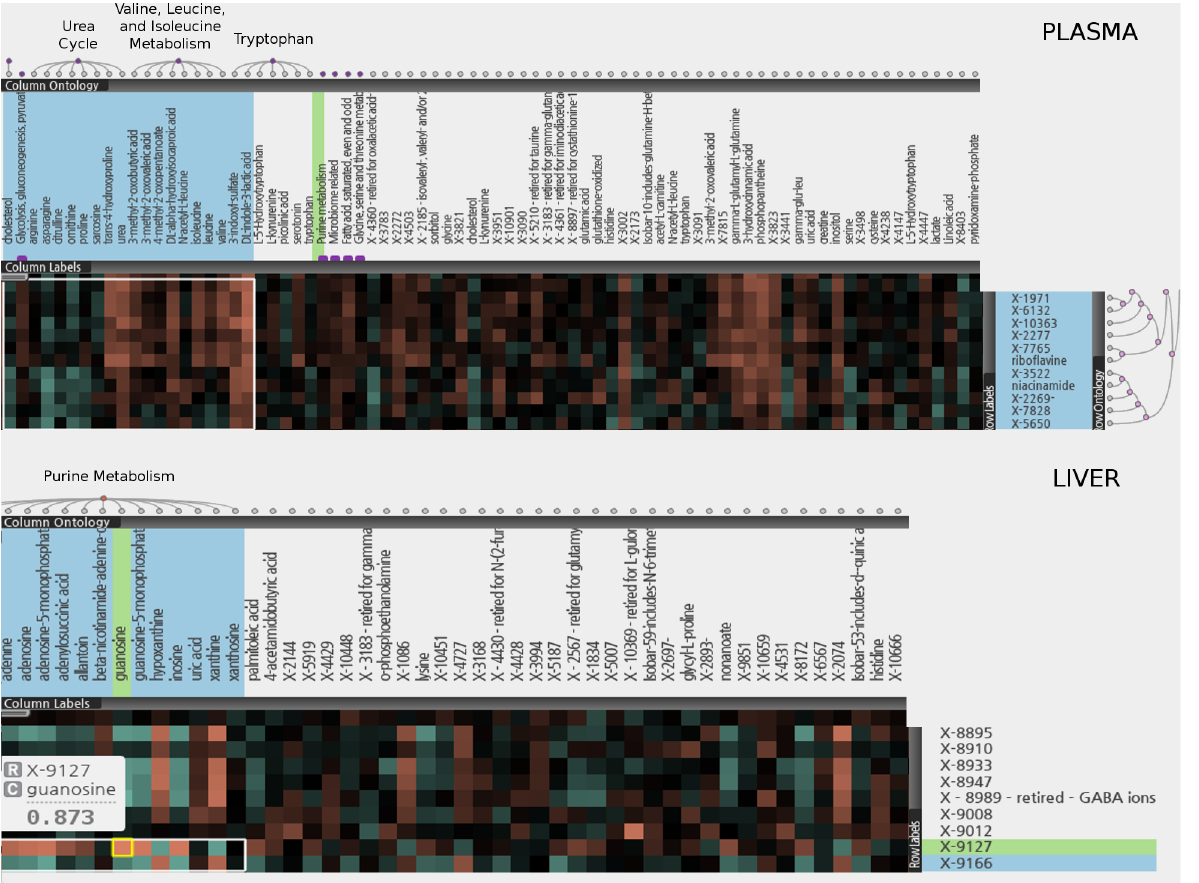
Fig 8. CoolMap and identification of unknown metabolites. CoolMap hierarchical clustering analysis was used for detection of relationships between metabolites, and biological processes in liver or plasma. The top and bottom panels, for plasma and liver, respectively, illustrate on how the “ known unknown ” metabolites within both plasma and liver samples were correlated with known metabolites that were grouped into ontologies to potentially aid in identification/ inference of function. This enabled the relevance of the “ known unknowns ” seen to be important for class separation by Random Forest and PLS-DA. Top panel: “ known unknown ” metabolites in plasma are related to urea cycle, branched chain amino acids, tryptophan and microbial metabolites. Bottom panel: “ known unknown ” metabolites in liver are related to Purine metabolism (see